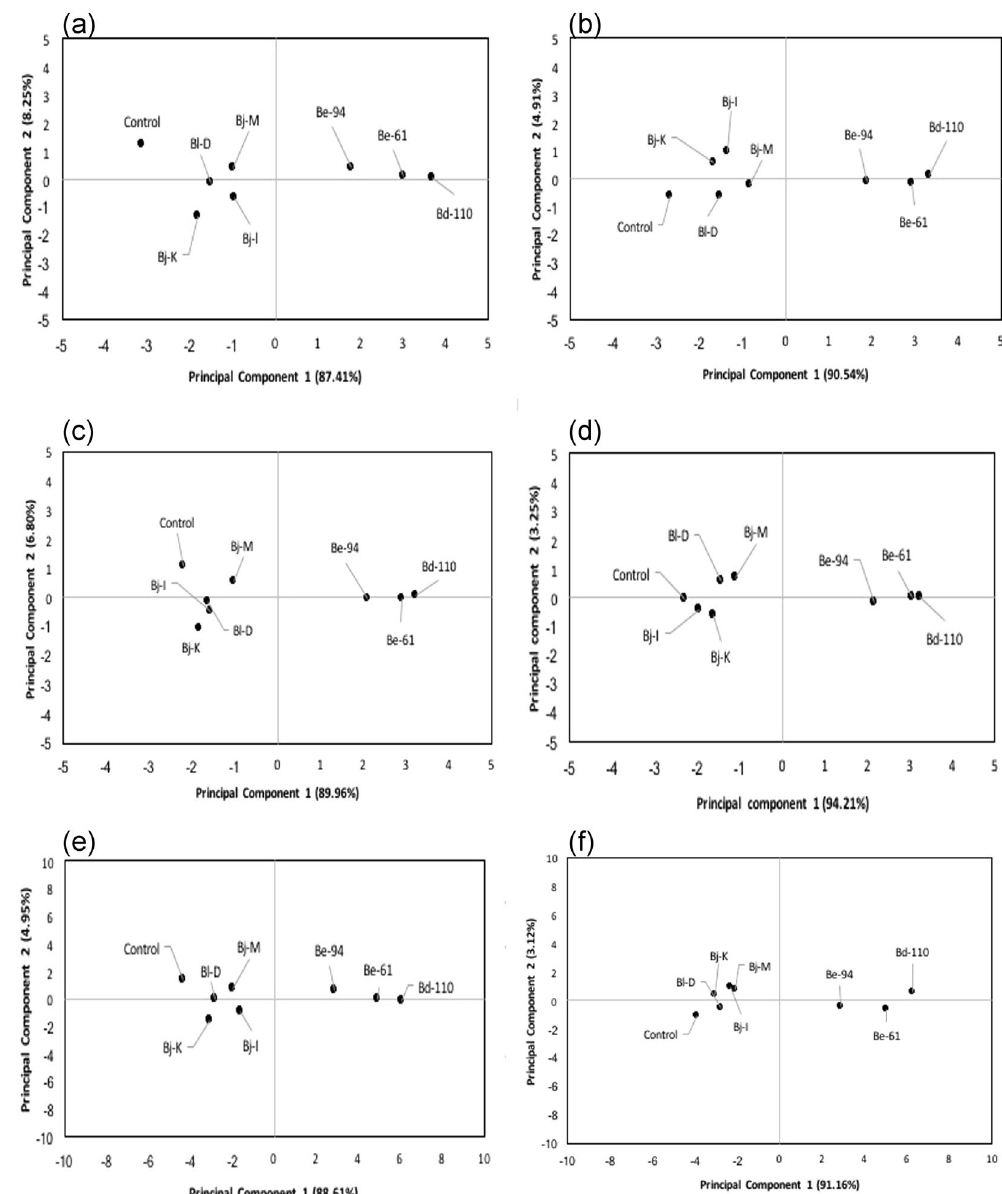
Figure 4. Principal component analysis (PCA) showing the inoculation effects of Rtx and non-Rtx bradyrhizobial strains for the image-based analysis of canopy measurements vs selected rhizosphere and plant growth parameters ( a , b ) specific to root nodulation and N fixation; canopy measurements vs rhizosphere soil parameters ( c , d ) related to microbial activities and plant nutrition; and canopy measurements vs p lant growth parameters ( e , f ) related to physiological and yield traits in soybean plants under watered and water-stressed